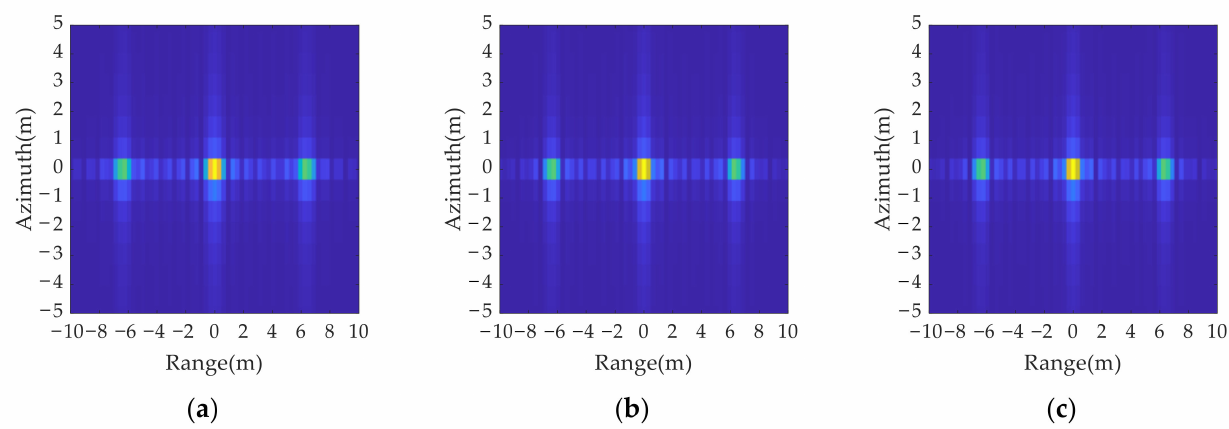
Figure 11. Anti-jamming results in range dimension with three different anti-jamming strategies: ( a ) case 1, where only bandwidth is changed; ( b ) case 2 where only pulse width is changed; ( c ) case 3, where both the bandwidth and pulse width are changed.